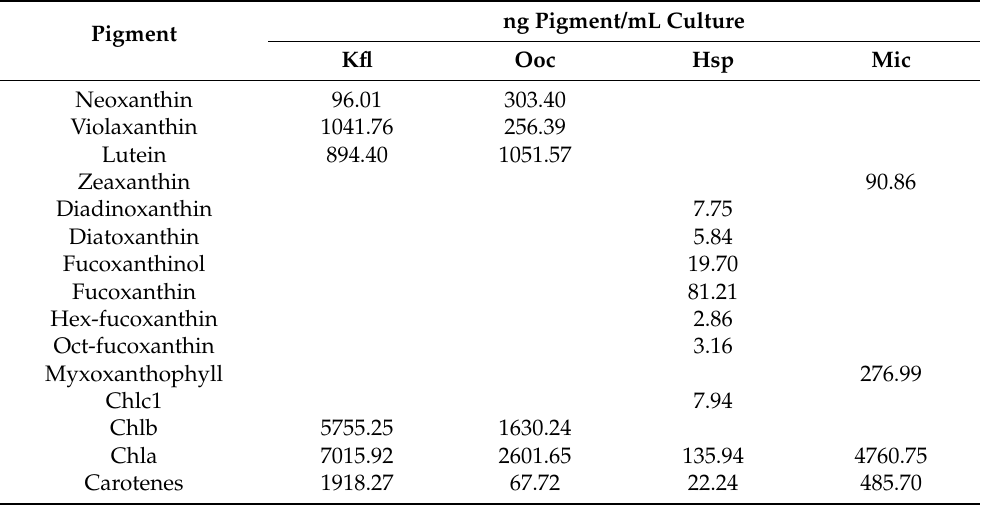
Table 1. Contents of representative photosynthetic pigments in each alga and cyanobacteria as determined by means of HPLC–DAD measurements. Abbreviations: Kfl, Klebsormidium flaccidum ; Hsp, Haslea spicula ; Ooc, Oocystis sp.; Mic, M. vaginatus ; Hex, hexanoyl; and Oct,